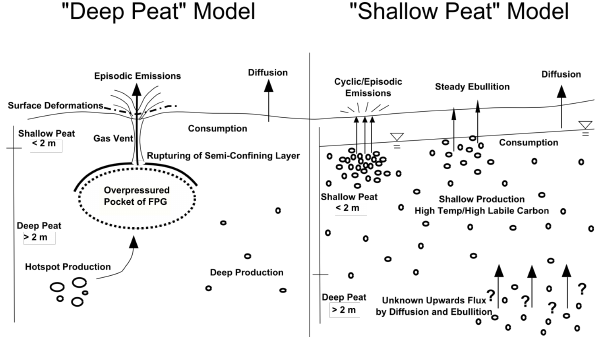
Fig. 1. Two competing models for ebullition of CH 4 from northern peatlands. Left: “deep peat” ebullition model modified from Glaser et al. (2004). Right: “shallow peat” ebullition model modified from Coulthard et al. (2009). Notice the unknown upward flux of CH 4 from deeper peat that was a “call for further research”. This study is a direct response to this call for